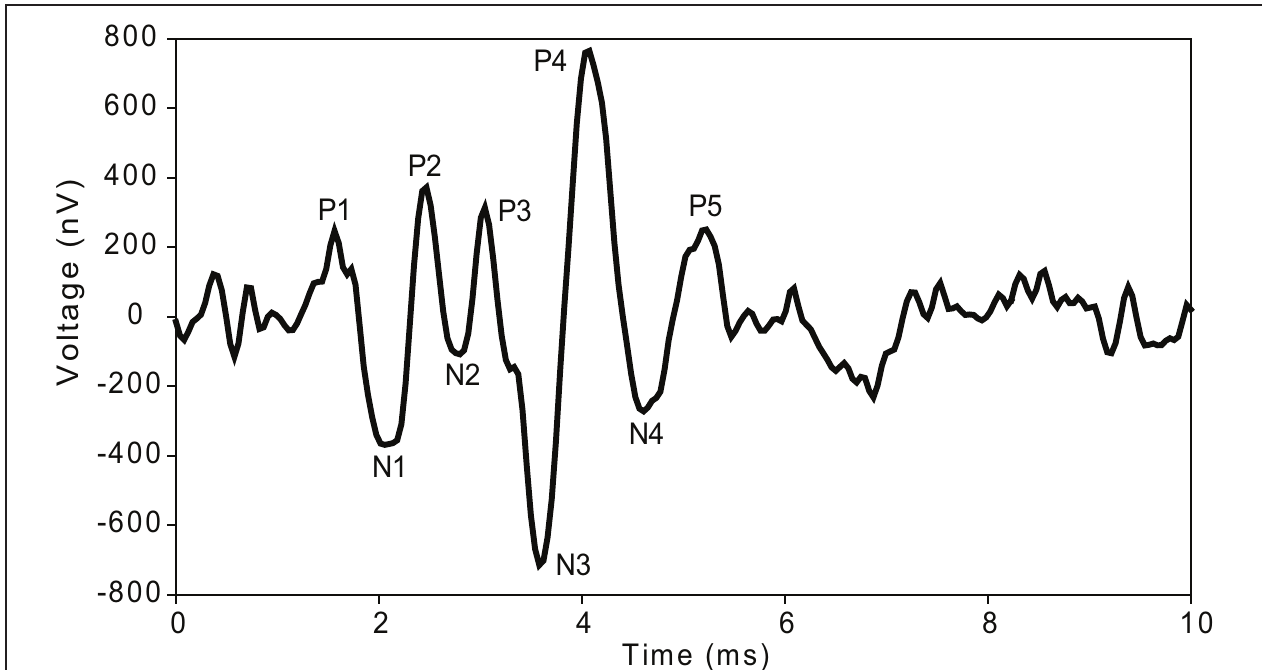
FIGURE 1 | ABR waveform morphology. Typical waveform (12kHz, 80dB SPL) illustrating the peaks (P) and troughs (N) of the ABR waves measured in guinea pig.